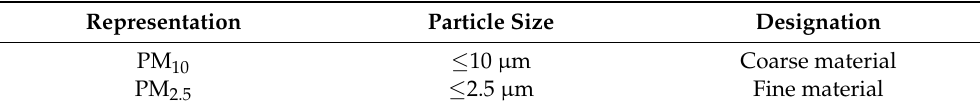
Table 1. Classification of particulate matter